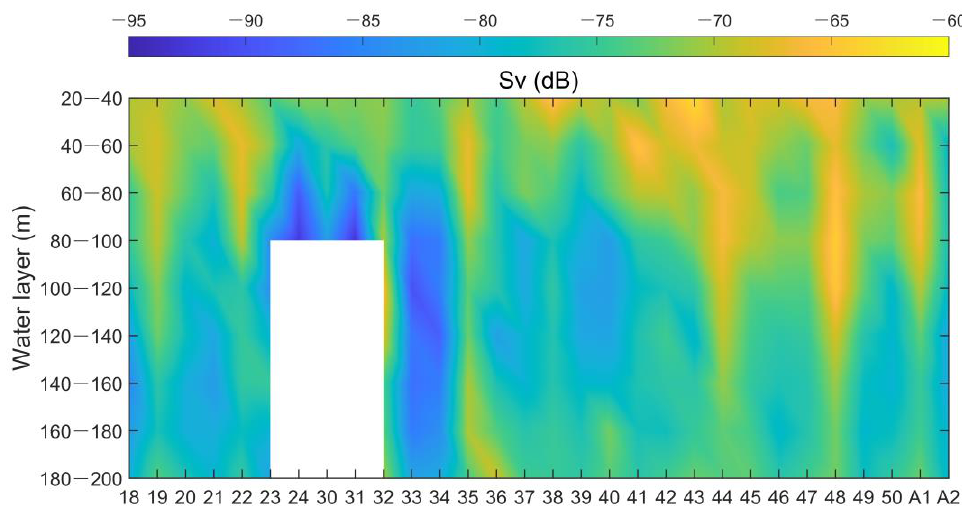
Figure 3. Distribution of scattering strength at different stations. The blank areas at Stations 24, 30, and 31 indicate that there were no valid data because data below 100 m were not collected at these stations.